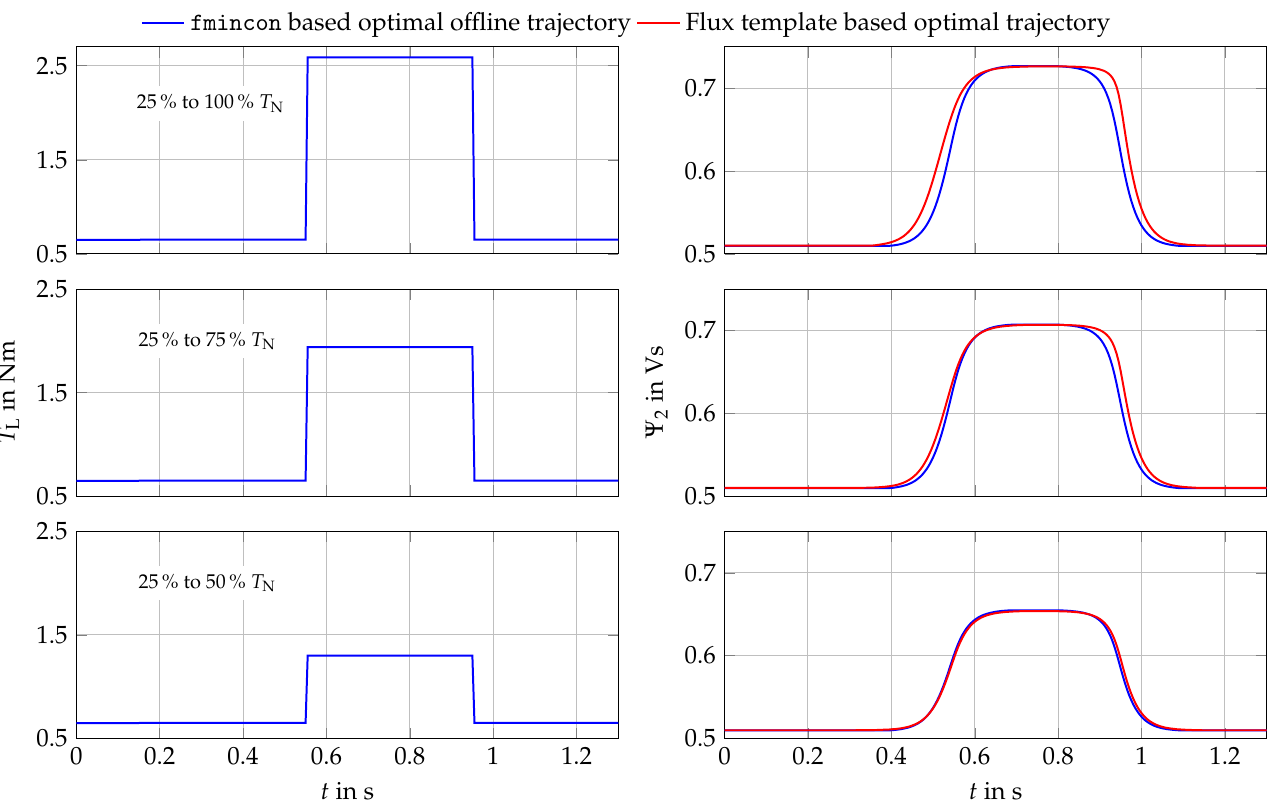
Figure 7. Flux trajectories for the motor specified in Table A1 for different torque